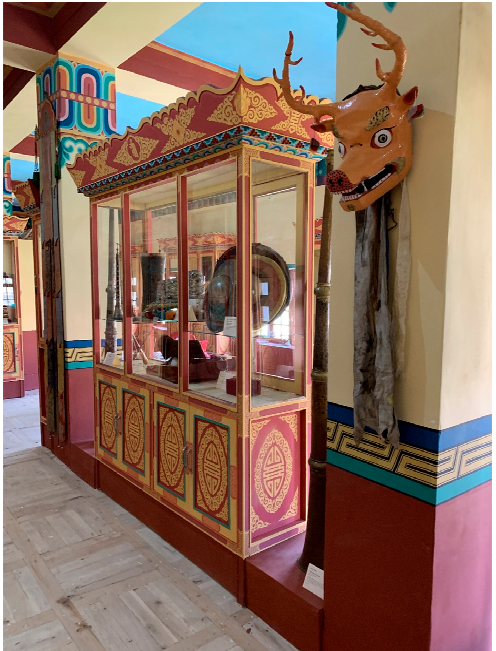
Figure 7. The new Chemde Monastery Museum, Ladakh (photo C. Bellini 2019).